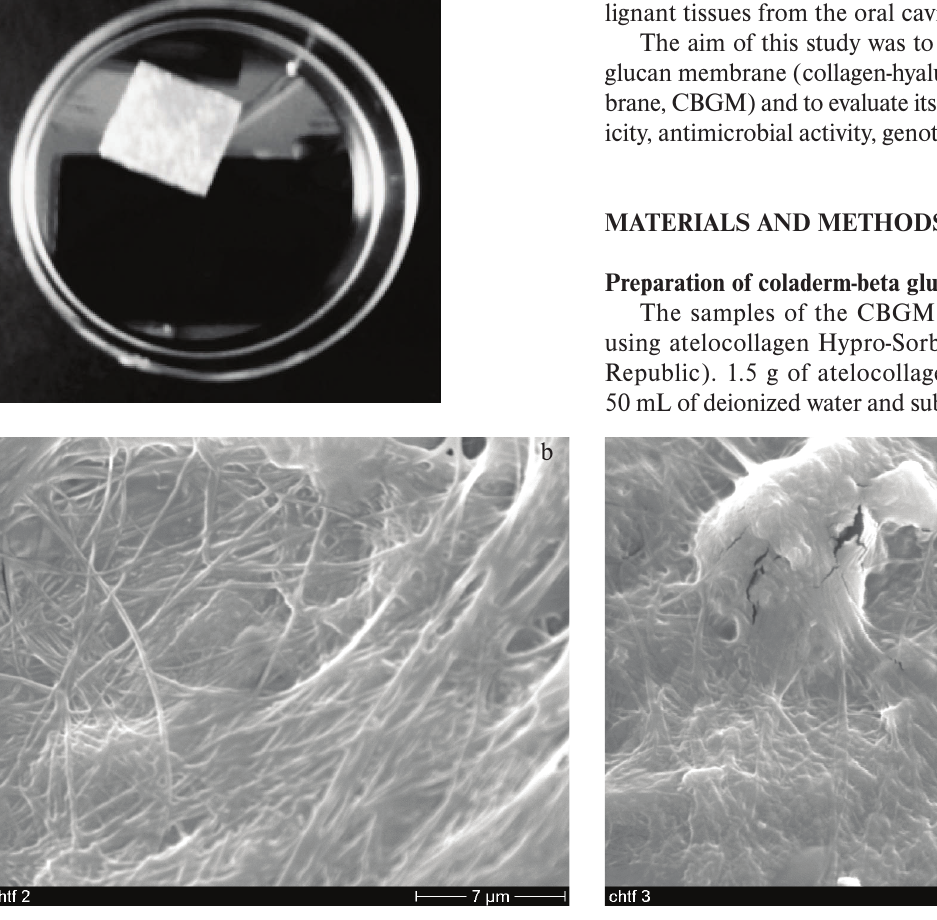
Fig. 1. Coladerm-beta glucan membrane structure: light microscopy – macrostructure (a), Scanning electron microscop – col- lagen fiber (b), collagen fiber ambient β-glucan granule (c). A beta glucan pacticle is indicated by the arrow 17